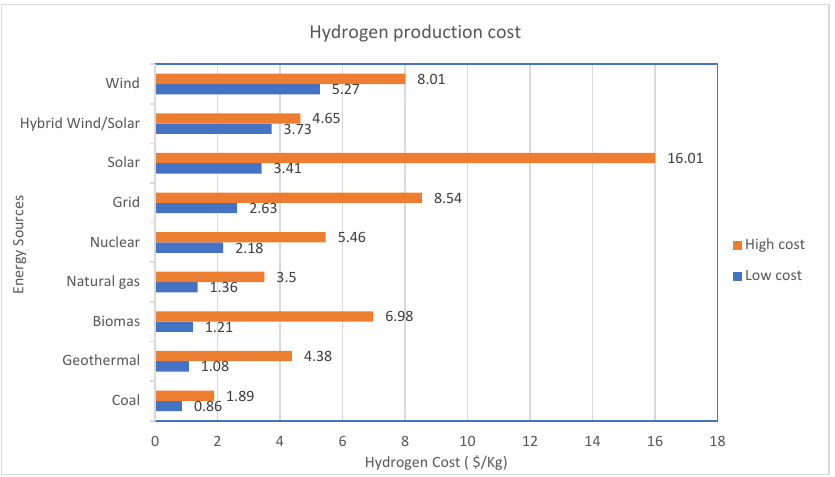
Figure 20. Hydrogen production cost for different energy sources.